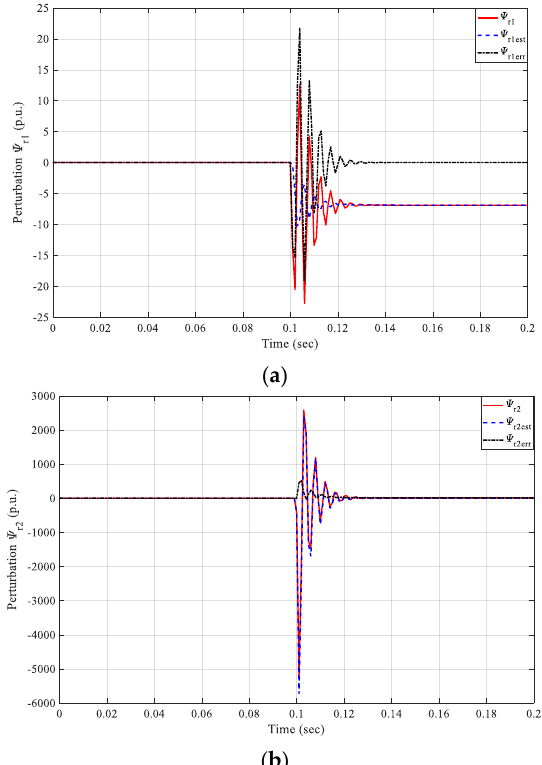
Figure 11. Disturbance rejection performance obtained under 20% voltage drop of rectifier. ( a ) Perturbation 𝛹 r1 and ( b ) perturbation 𝛹 r2 .